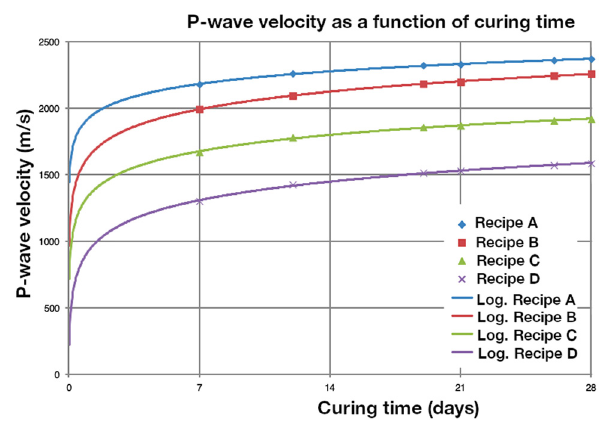
Figure 11: P - wave velocity over curing time at 20°C .